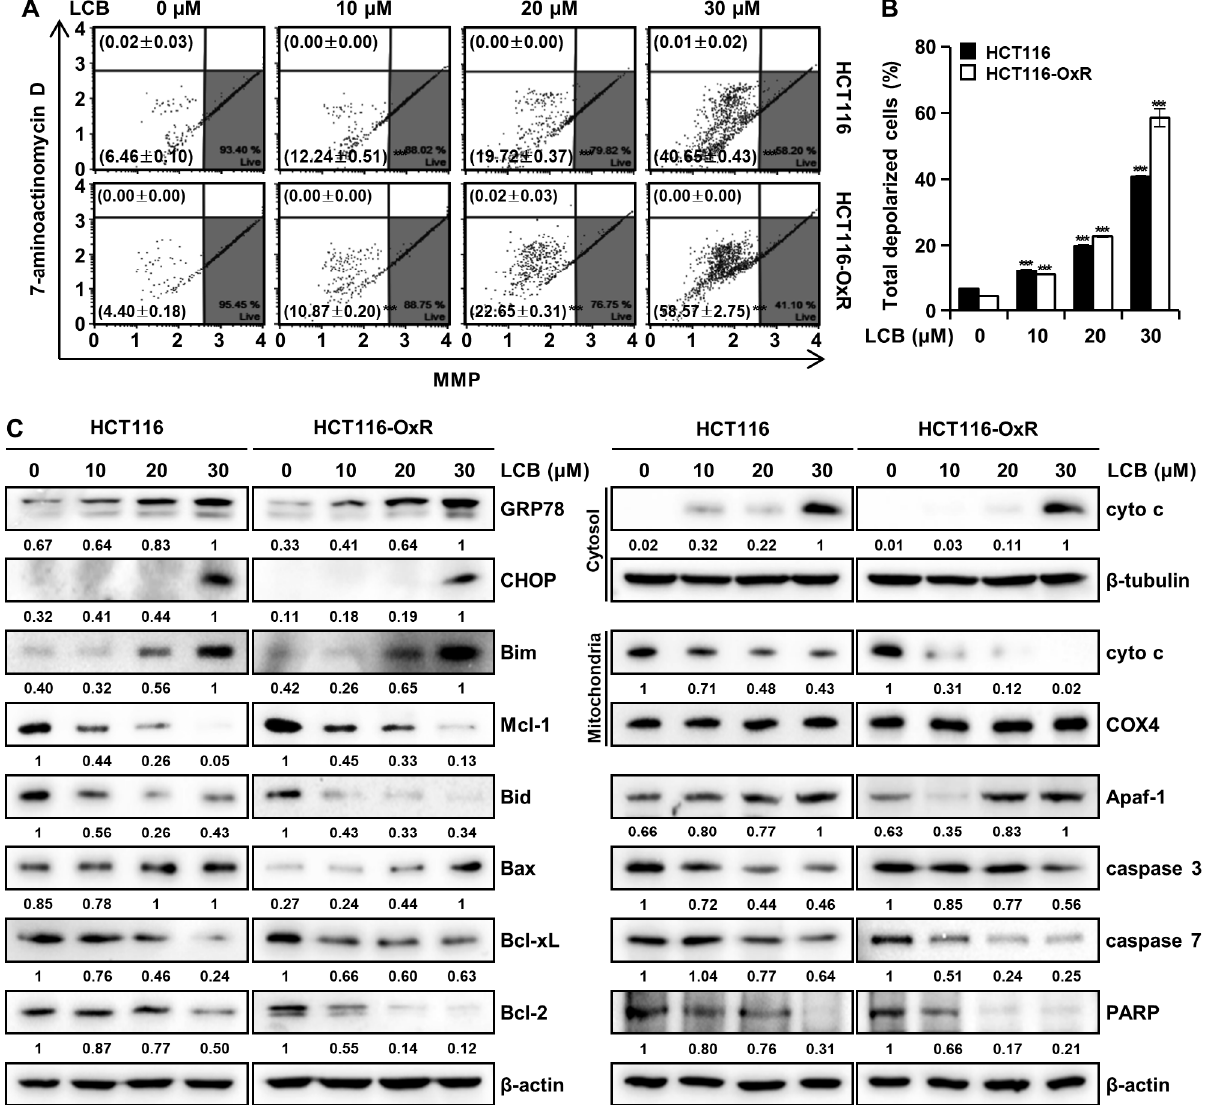
Figure 4. LCB induces apoptosis in CRC cells by disturbing the mitochondrial membrane potential (MMP) and regulating endoplasmic reticulum (ER) stress and apoptosis-related proteins. Cells were treated with 0, 10, 20, and 30 μ M LCB for 48 h. ( A , B ) Flow cytometry analysis of MMP using the Muse ® MitoPotential Kit. *** p < 0.001 versus the control group. ( C ) Western blot analysis of ER-stress- and apoptosis-related proteins in CRC cells. Effect of LCB on the expression of GRP78, CHOP, Bim, Mcl-1, Bid, Bax, Bcl-xL, Bcl-2, cytochrome c (cyto c), β -tubulin, COX4, Apaf-1, caspase 3, caspase 7, and PARP proteins. β -tubulin, COX4, and β -actin were used as internal controls. Protein bands were quantified using Image J